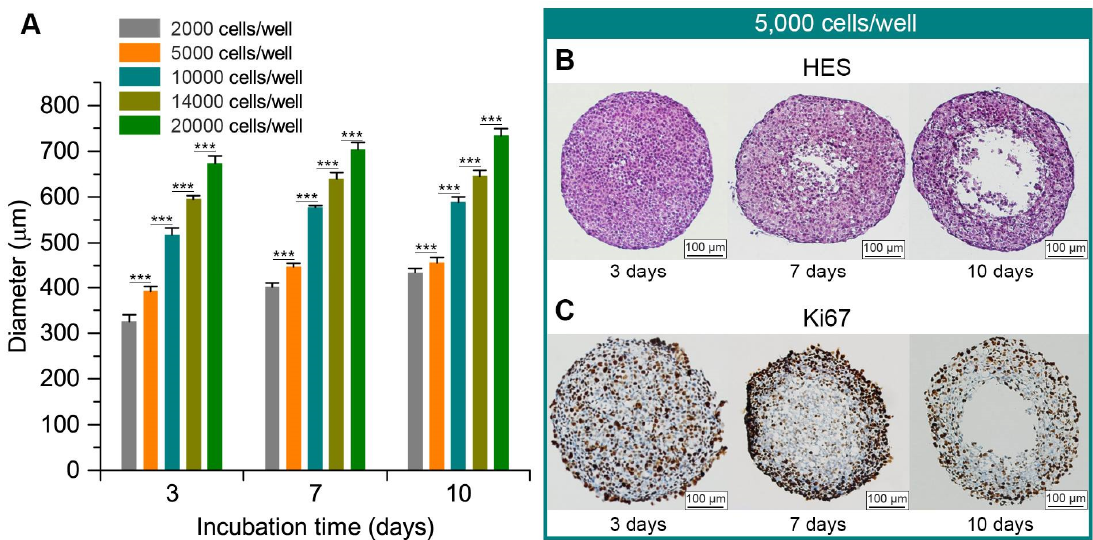
Figure 1. ( A ) Spheroid growth kinetics initiated with different cell concentrations. FaDu cells were placed in different concentrations (from 0.5 × 10 4 to 10 5 cells/ml) in agarose pre-coated 96-well plates and then stored at 37 °C, in a humidified atmosphere with 5% CO 2 . Growth of the spheroids was monitored from day 3 to day 10 with phase-contrast microscopic controls. *** p < 0.00001. ( B ) and ( C ) Paraffin sections of 3-, 7- and 10-day spheroids initiated from 5 000 cells/well. Paraffin sections of 3-, 7- and 10-day spheroids initiated from 5 000 cells/well were stained with Hematoxylin-Eosin-Safran (HES) ( B ) and Ki67 ( C ). The scale bar represents 50 µm.